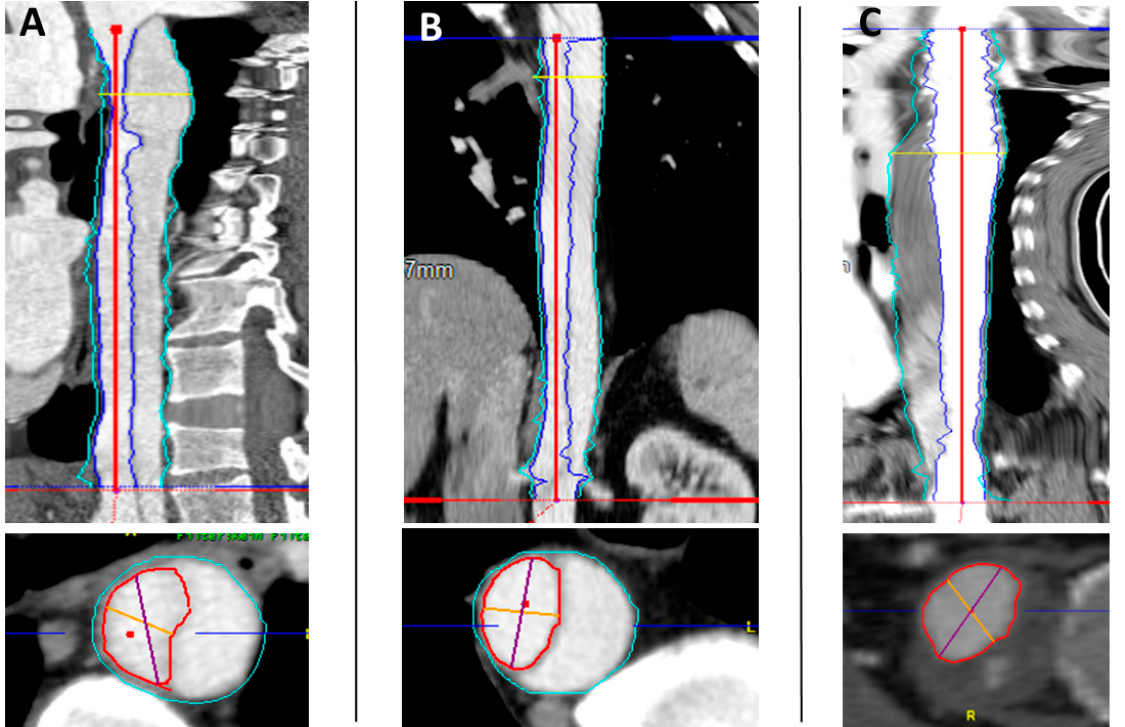
Figure 1. Exemplary CT displaying curved planar and straight multiplanar reconstruction before surgery ( A ), 24 months after hemi-arch repair ( B ), and 24 months after FET implantation ( C ) according to the aforementioned stepwise approach using Aquarius iNtuition (TeraRecon Inc., Foster City, CA, USA). Red line: edited centerline. True lumen was selectively marked and measured separately and manually for each CT slice before and after hemi-arch repair/FET implantation (marked red area). Blue line marks the true lumen in the upper part of the figures. Turquoise line marks the total